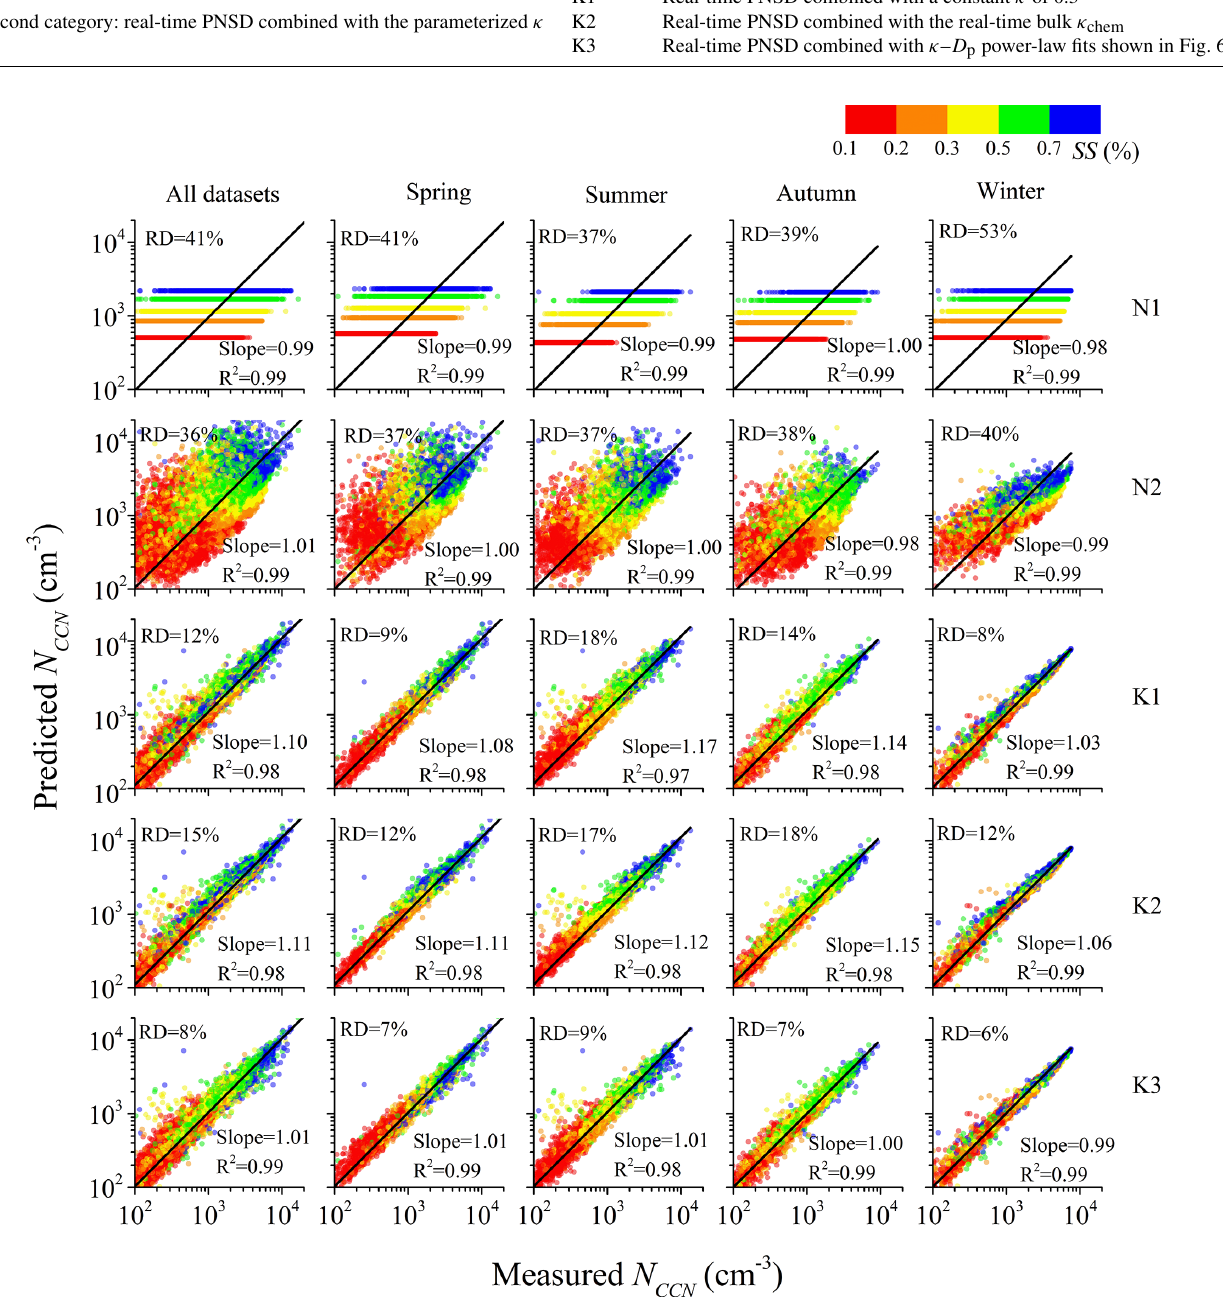
Figure 7. Predicted vs. measured CCN number concentration ( N CCN ) for different seasons. The predicted N CCN is calculated from five different schemes with a detailed introduction shown in Table 3. Color bar represents the different supersaturation (SS) conditions. Black lines are the linear fits. The slope and R 2 of the linear regression and the median relative deviation (RD) between the predicted and measured N CCN are shown in each panel. Each row represents the results using the same scheme in different seasons. Each column represents the results using different schemes in the same